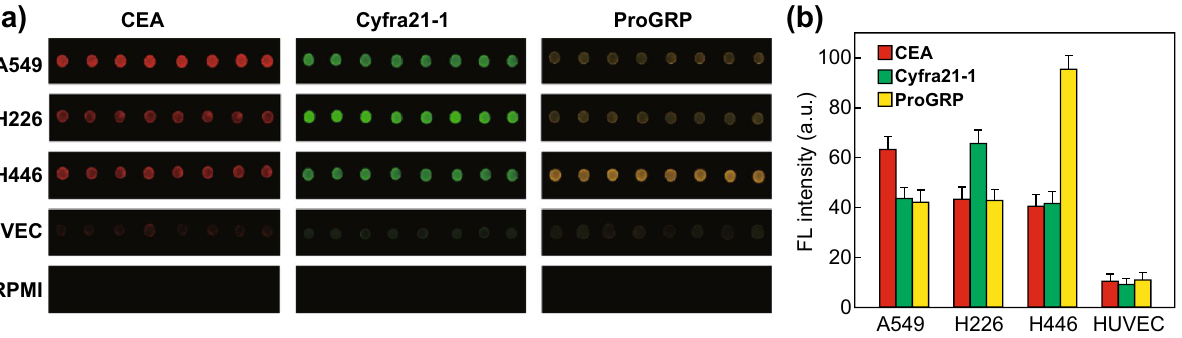
Fig. 4 a Fluorescence images of exosomes derived from different cell lines using three different tumor-specific QD probes. b Average expres- sion levels of three lung cancer markers measured in different cell lines